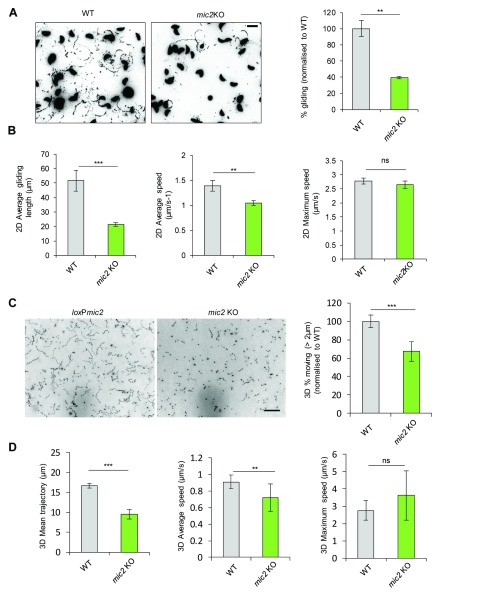
Gliding initiation and gliding distance are affected by
mic2 KO attachment defect but not maximal speed.
A) Trail deposition assay of WT parasites compared to
mic2 KO. Mean values of three independent assays are shown ± SEM and **
p-value <0.01 in a two-tailed Student’s t-test. Scale bar 5 μm
B) Kinetic analysis of 2D helical gliding. Data were analysed using auto-tracking software. Mean values of three independent assays are shown ± SEM, ***:
p-value <0.001 in a two-tailed Student’s t-test.
C) Representative maximum intensity projections of 3D Matrigel-based motility assays comparing WT to
mic2 KO parasites (left) and % of parasites moving (right) normalised to WT. Scale bar 50 μm
D) Analysis of 3D trajectories; mean values of three independent assays are shown ± SD, ***:
p-value <0.001 in two-way Anova with Sidak’s multiple comparisons test.